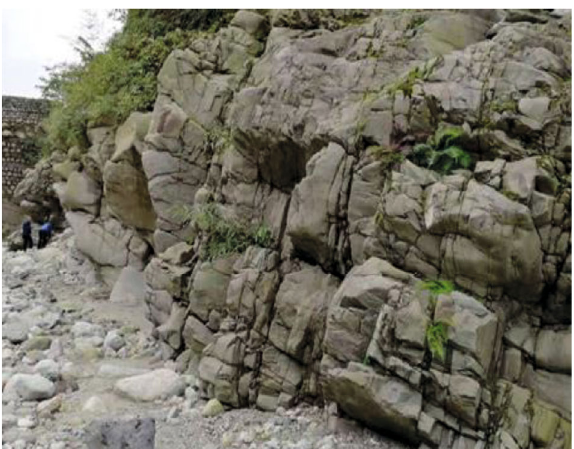
Figure 1: The outcrop of the Triassic Xujiahe sandstones in the Sichuan Province of